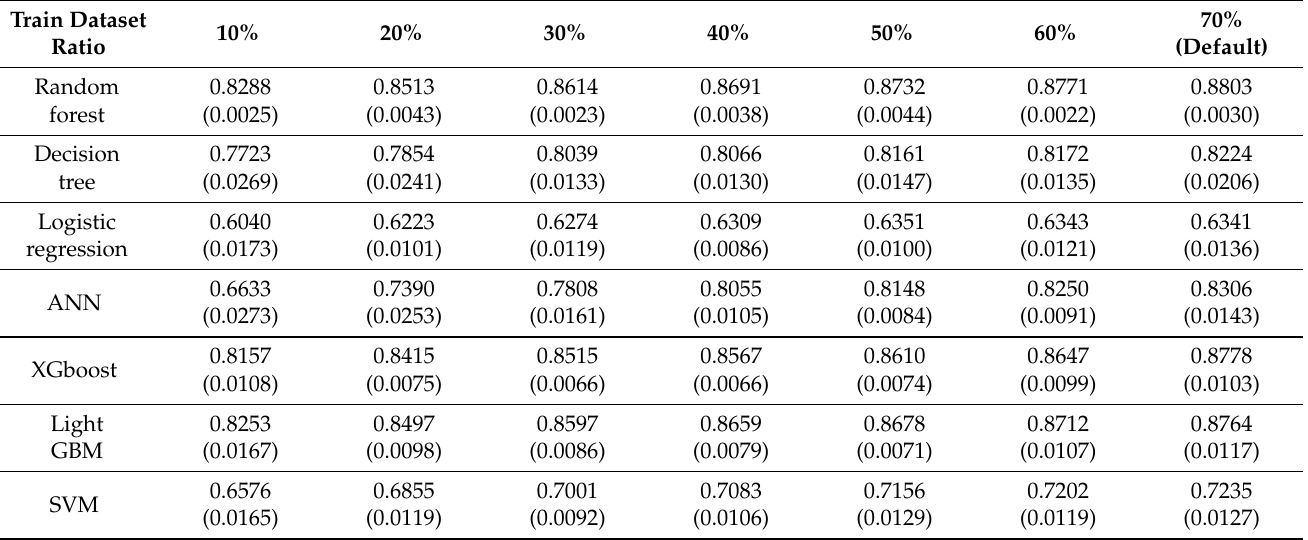
Table 16. Changes of hepatitis B risk association model’s performance according to the number of train dataset.